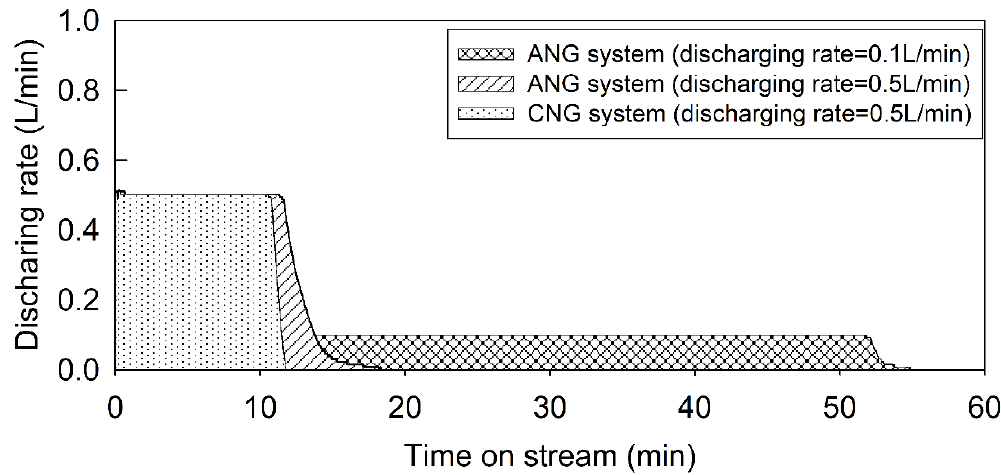
Figure 6. Variation of delivery capacity with specific flow rate for constant pressure charging.